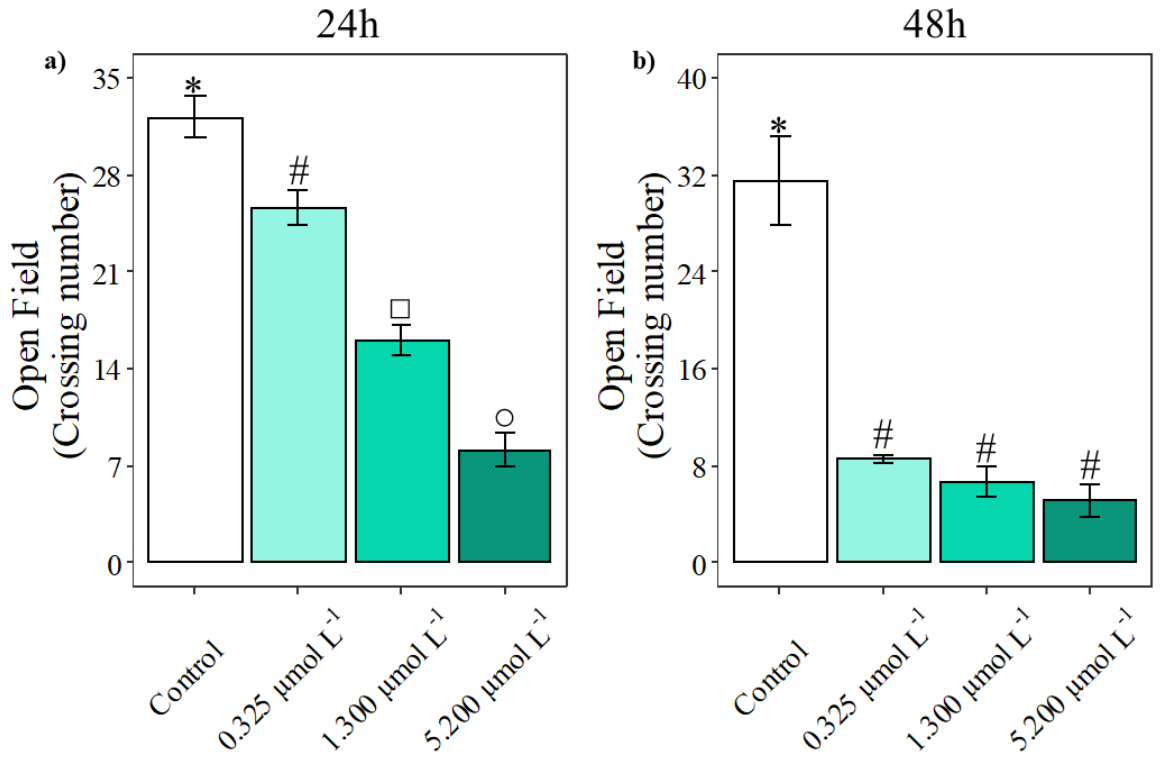
Figure 3. Locomotor behavior of Drosophila melanogaster exposed to three concentrations of 2-Phenylethynyl- Butyltellurium (PEBT) verified through the open field test, in 24h (a) and 48h (b). * Significant difference compared with #, ◻ and ○. # Significant difference compared with *, ◻ and ○. ◻ Significant difference compared with *, # and ○. ○ Significant difference compared with *, #, and